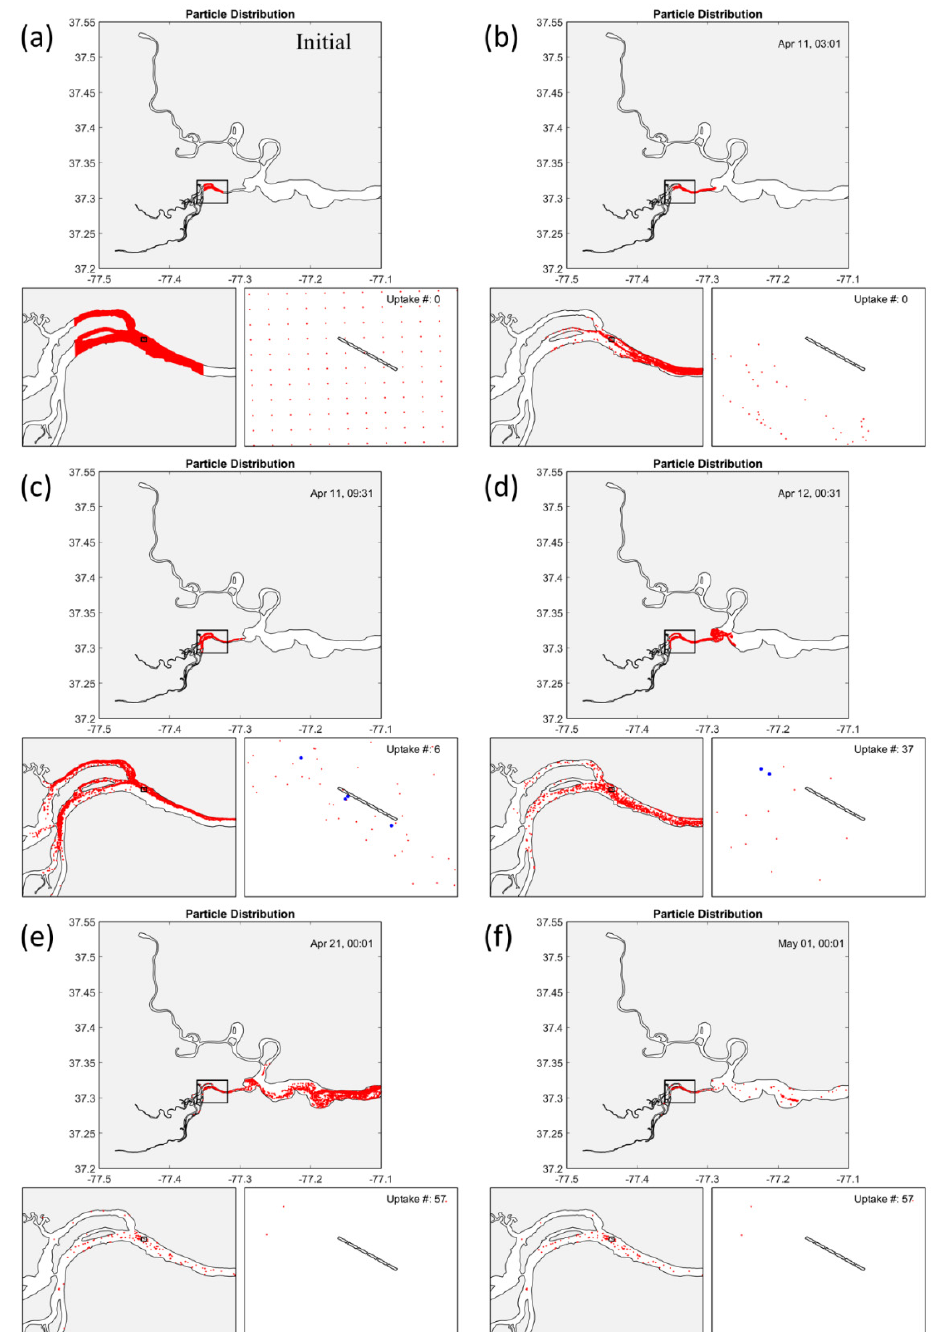
Figure 6. Distribution of particles (red dots) in scenario 1. ( a ) Initial distribution at 11 April 2017. ( b ) After 3 h. ( c ) After 9.5 h. ( d ) After 1 day and a half hour. ( e ) After 10 days. ( f ) After 20 days. Blue dots denote those particles that are eventually removed by the intake.